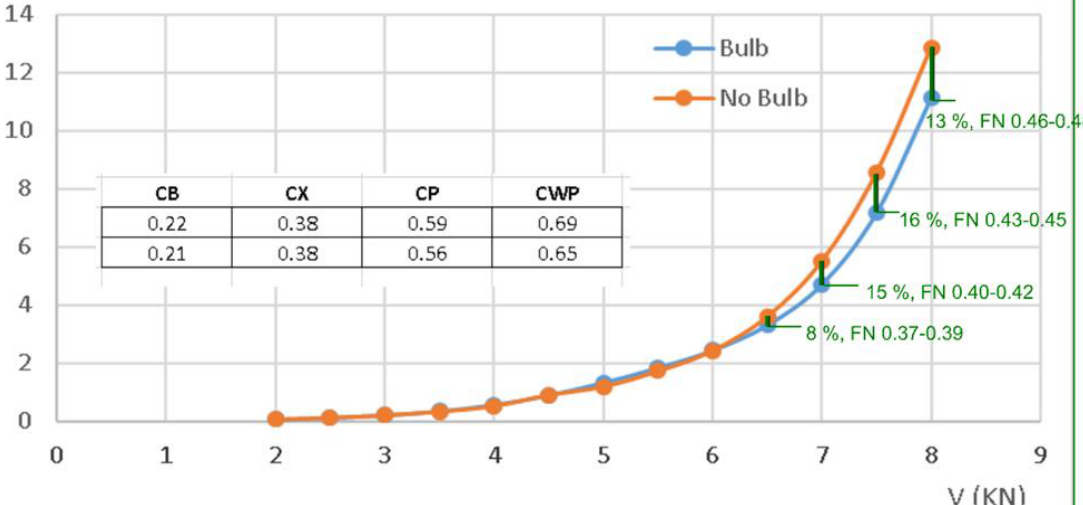
Figure 18. Power reduction for FAO1 vs. FAO2, light conditions.